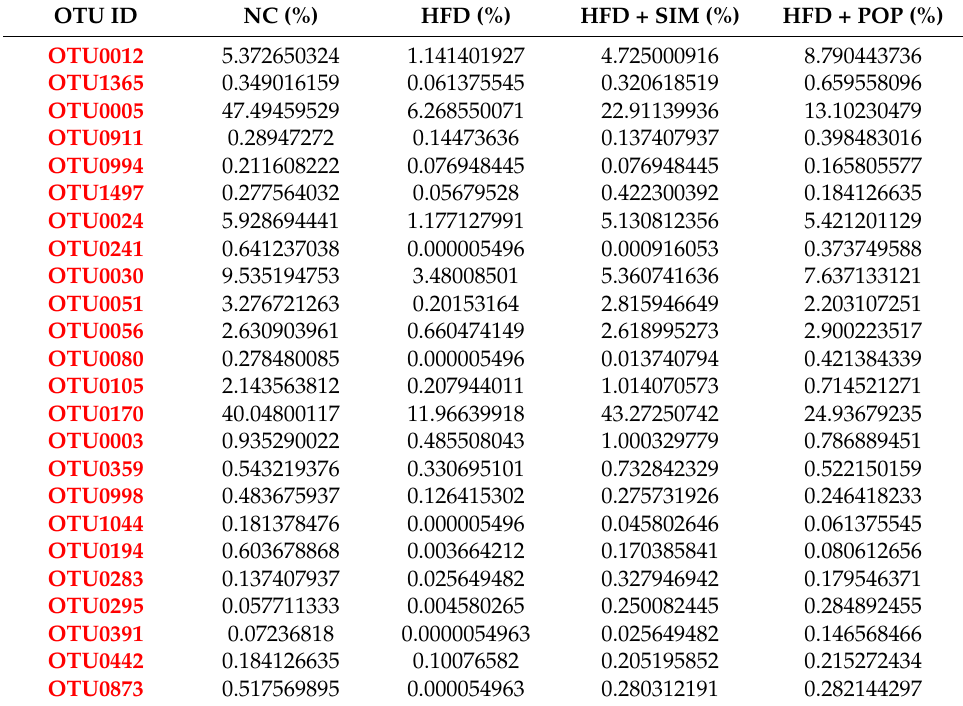
Table A2. Fifty key OTUs responding to POP, as identified by redundancy